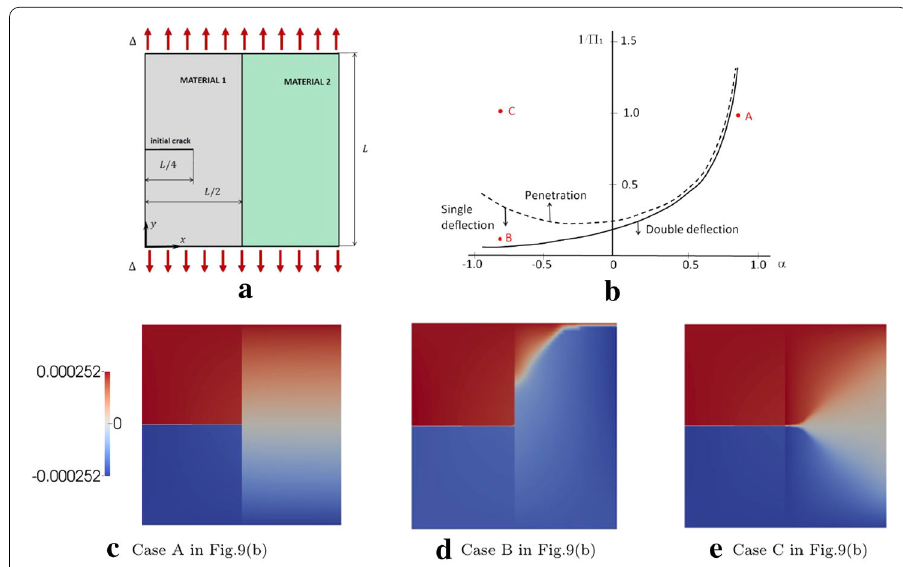
Fig. 9 a Geometry of the tensile test of a bi-material system; b curve which separate the crack penetration, crack single deflection and crack double deflection cases; transition from double deflection ( c ) to single deflection ( d ) and crack penetration ( e ) for a brittle interface ( (cid:4) 2 → 0) varying the ratio 1 /(cid:4) 1 . The contour plots scale is a dimensional vertical displacement (from [37])